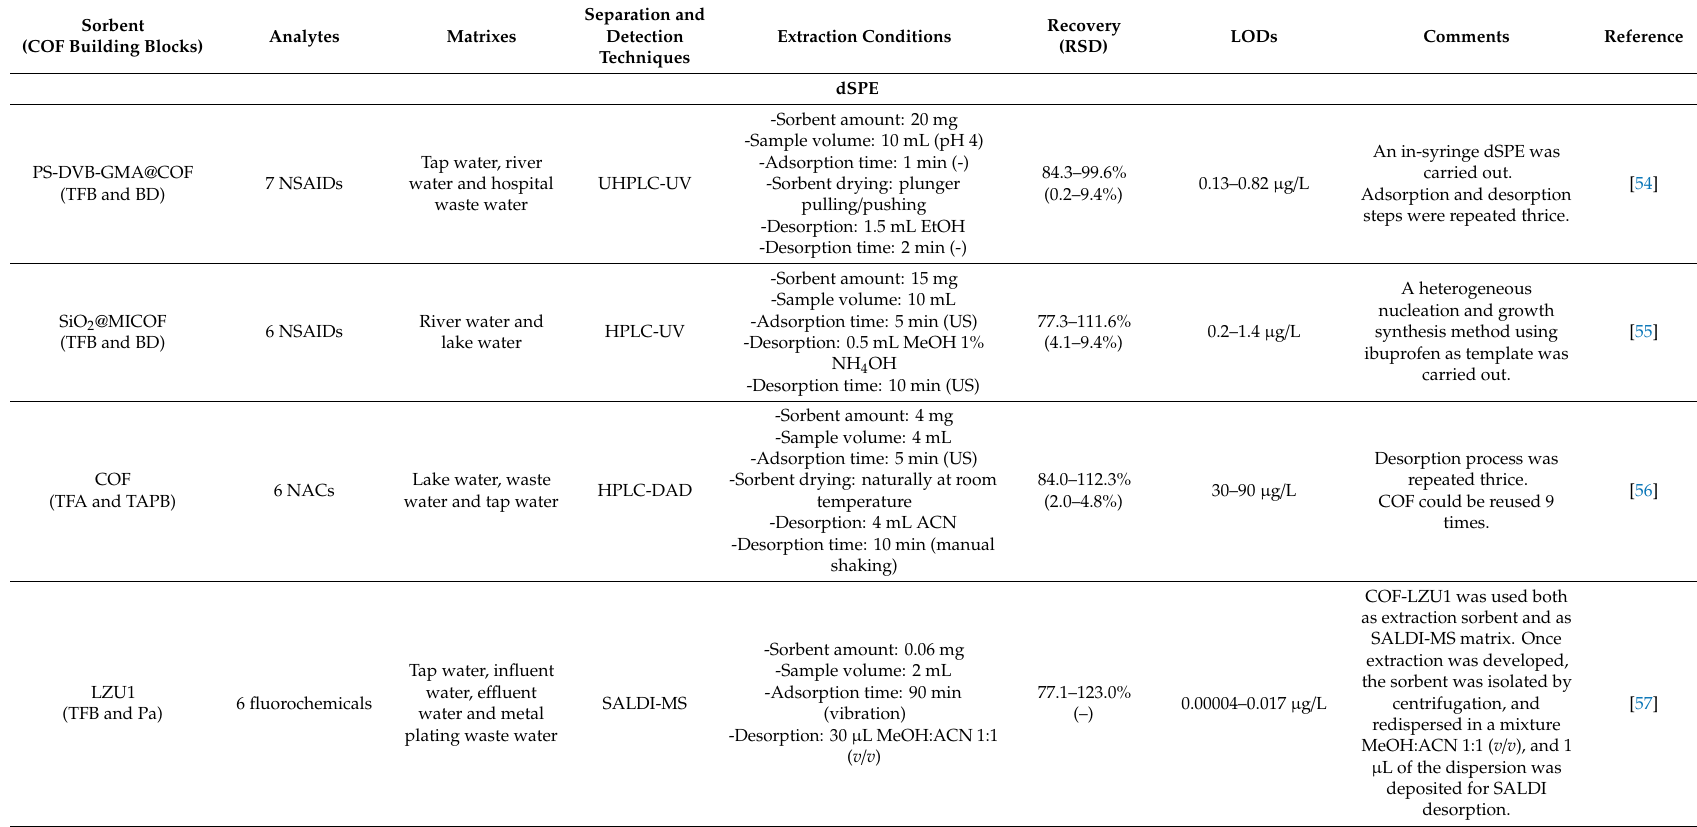
Table 2. Applications of COFs as sorbents in dSPE and